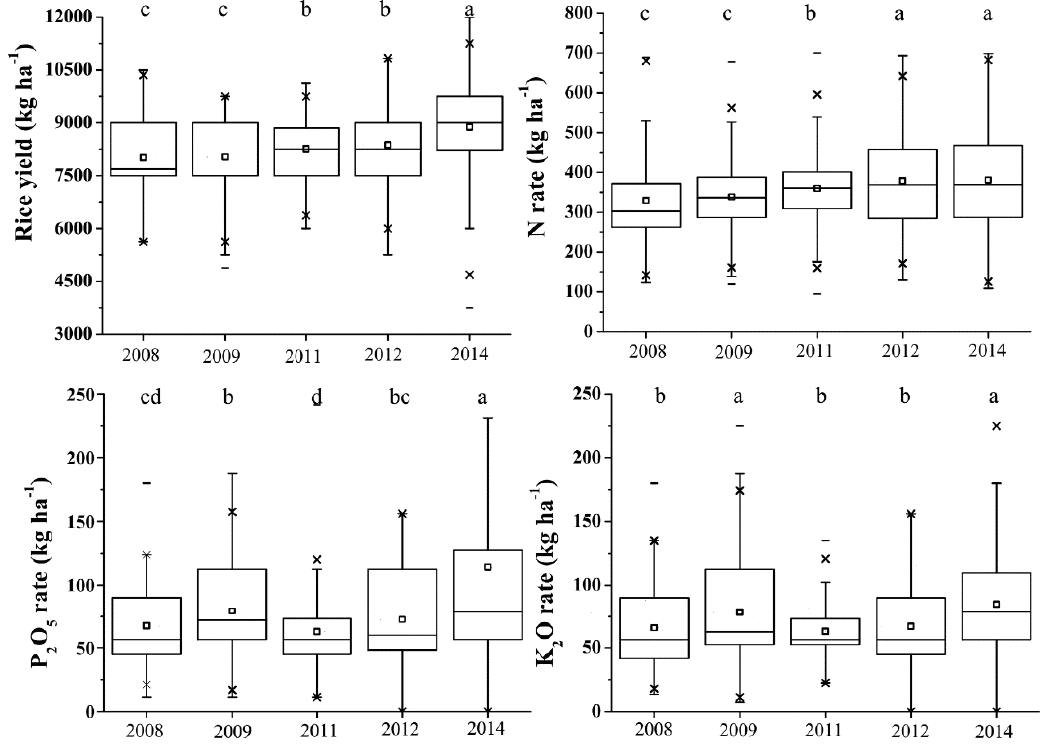
Figure 2. Descriptive statistics from farms surveys conducted in Jiangsu province, China, from 2008 to 2014 including rice yield and nitrogen (N), phosphorus (P 2 O 5 ) and potassium (K 2 O) application rates (2008, n = 128; 2009, n = 434; 2011, n = 301; 2012, n = 250; 2014, n = 242). Data in 2010 and 2013 are not presented due to low sample size. Different letters represent statistically significant differences in these indicators among years at p < 0.05 level. Symbols: horizontal lines and squares within boxes indicate median and means, respectively; lower and upper boundary of boxes, 25th and 75th percentiles; lower and upper error bars, 10th and 90th percentiles; crosses, 1th and 99th percentiles; short-lines, maximum and minimum values.